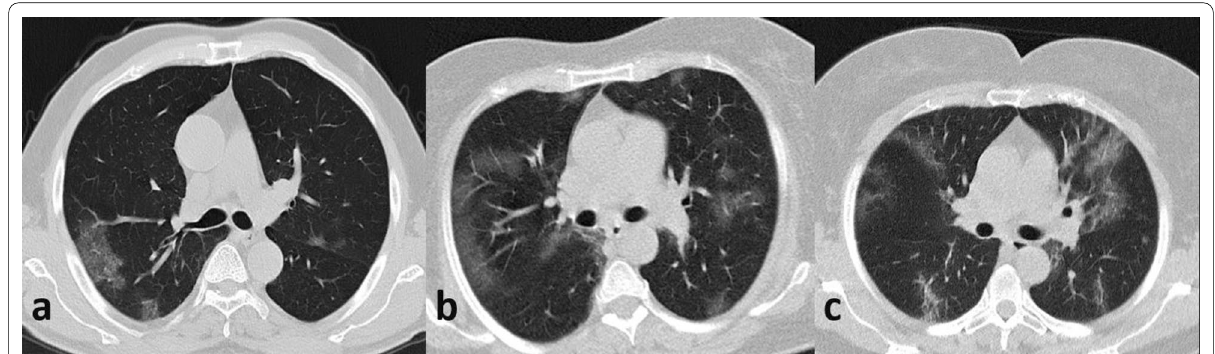
Fig. 1 Example cases of three patients with typical findings of COVID-19 in FDCT ( a ) and LDCT ( b , c ). Adequate image quality is obtained both in full-dose and ultra-low dose CT chest protocols. a FDCT—normal BMI—DLP: 192 mGy*cm. b LDCT—normal BMI—DLP: 20 mGy*cm. c LDCT— Elevated BMI—DLP: 26